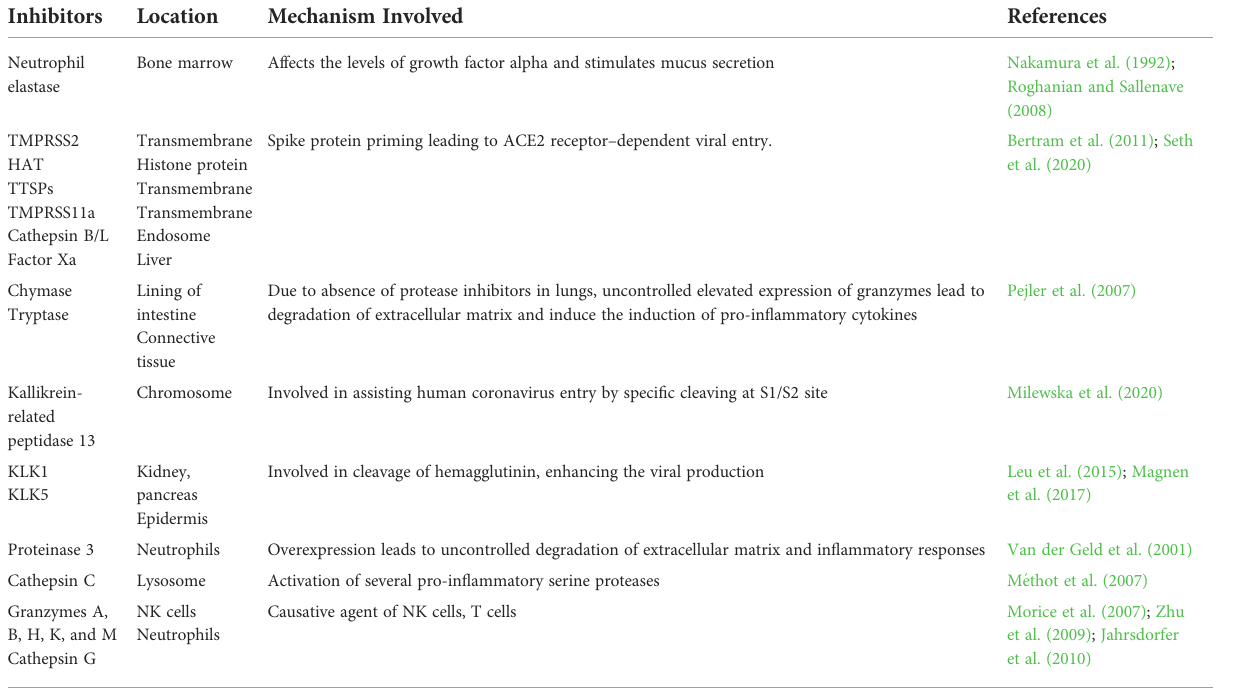
TABLE 1 Potential host proteases that inhibit SARS-CoV-2 virus.